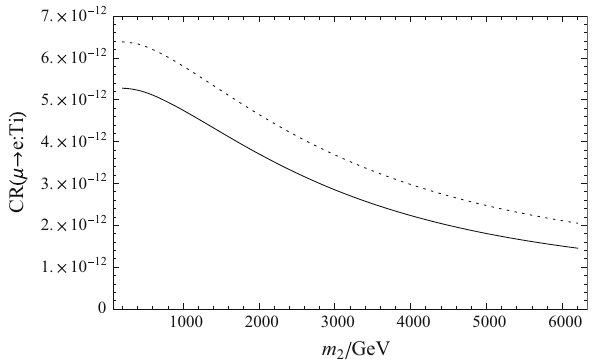
Fig. 7 With tan β = 2 . 0, S 2 m = 10TeV 2 , M Lf = 10 4 GeV 2 , tan β L = and V Lt = 3000GeV, μ → e conversion rate in nuclei 2 . 0, g L = 1 6 Ti versus m 2 is plotted for m 1 = 2000GeV (solid line) and 1000GeV (dotted line)